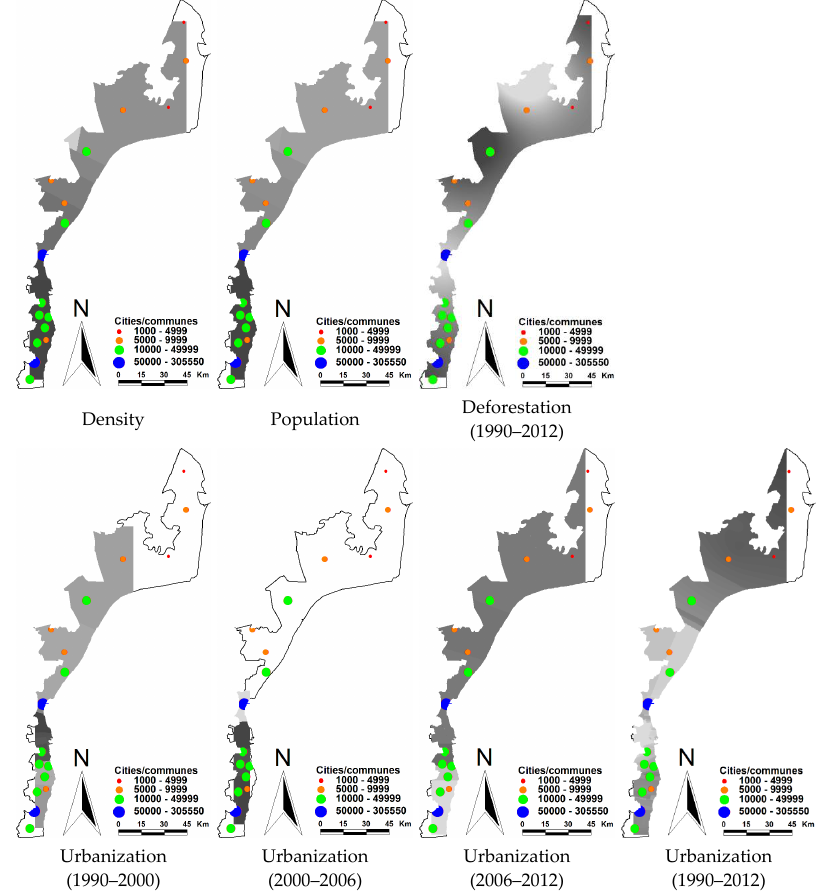
Figure 6. Urbanization and deforestation of the Romanian shoreline, in relationship with population and its density. The darker shades correspond to higher values. The red circles represent the centers of administrative units, with sizes proportional to the following population classes: (1) up to 999, (2) 1000–4999, (3) 5000–9999, (4) 10,000–49,999, and (5) 50,000 and over.